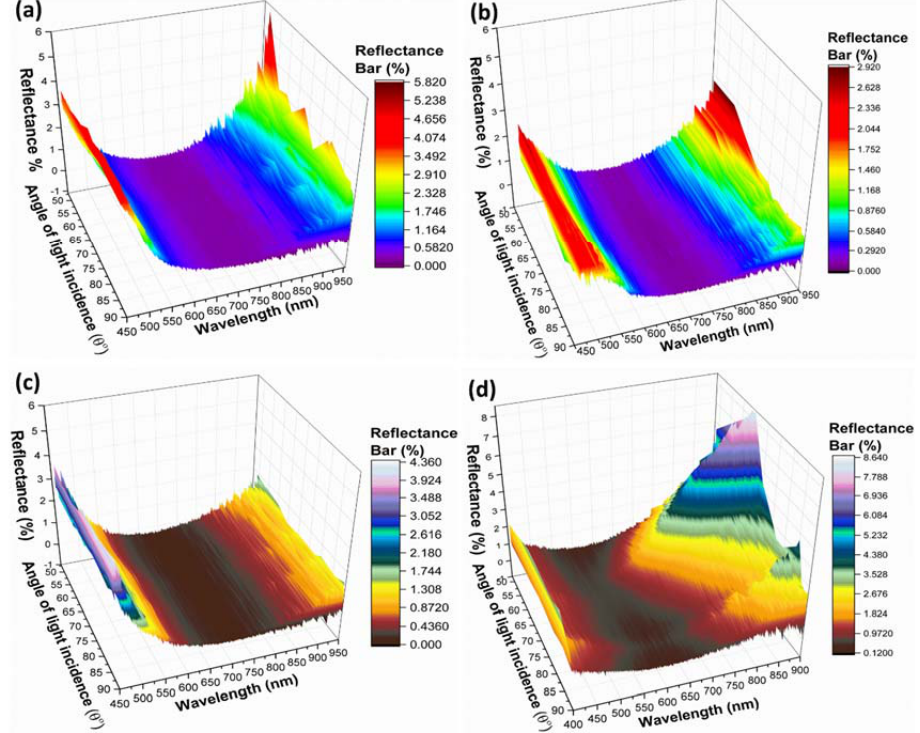
Figure 6. Omnidirectional AR efficiency of bilayer SiO 2 AR coating on BK7 substrate at a different angle of light incidence: ( a ) nanozigzag, ( b ) C ‐ shape, ( c ) nanohelix, and ( d ) slanting nanostructure.